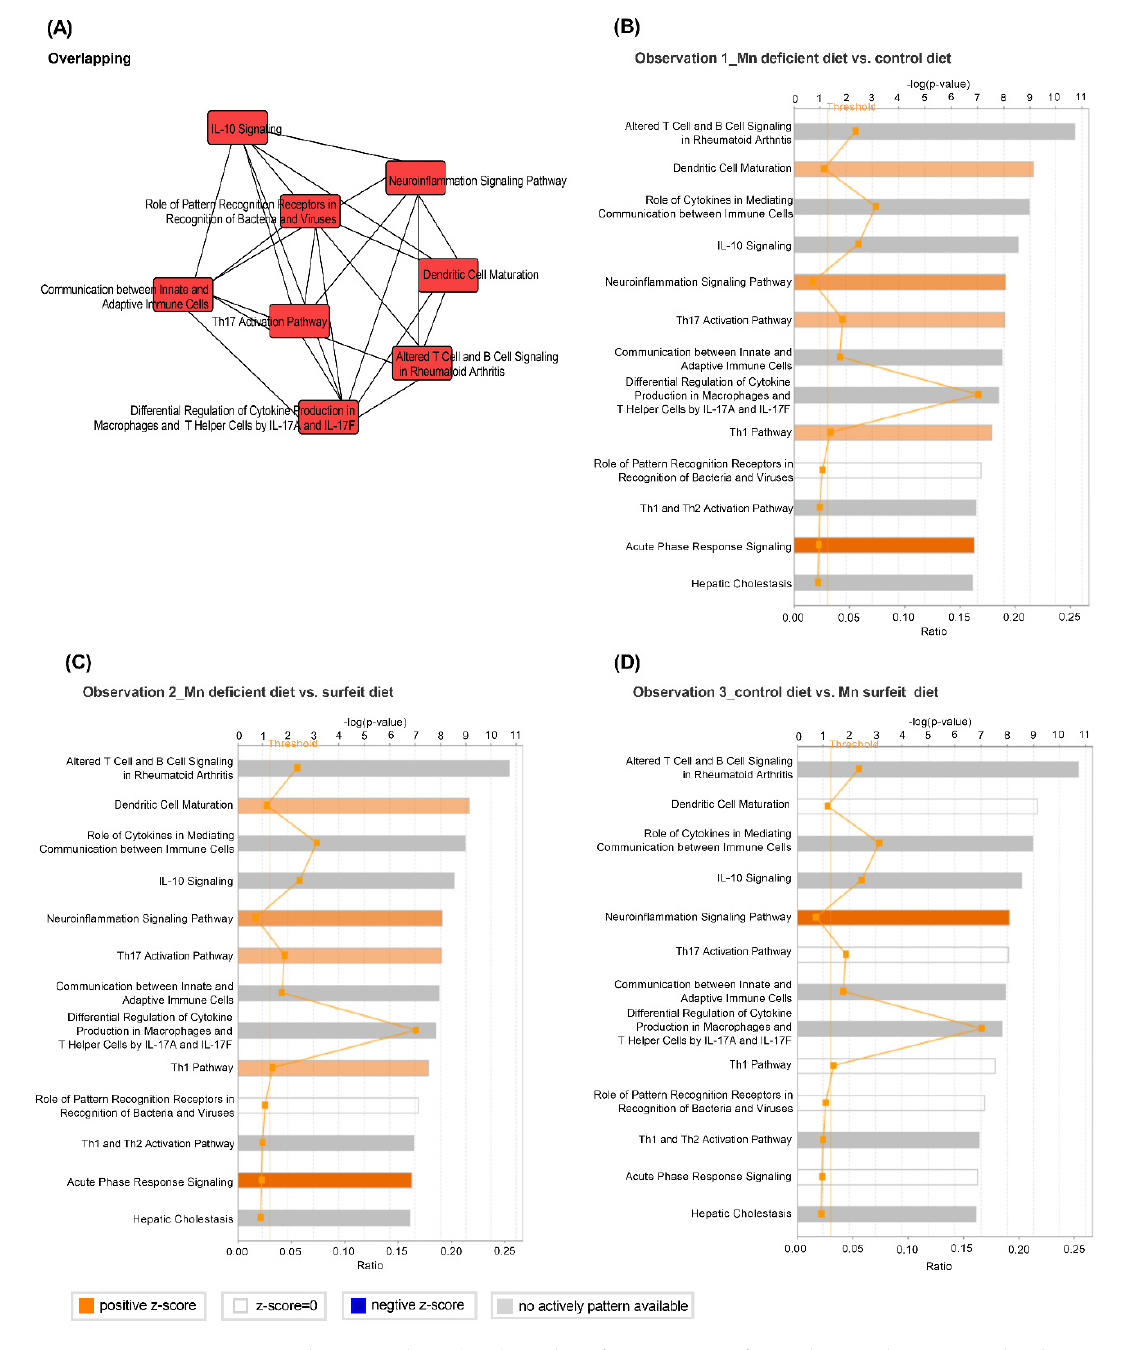
Figure 6. Ingenuity-pathway analysis (IPA) to identify activation of signaling pathways involved in dietary Mn and S . Typhimurium infection in broilers. ( A ) Top eight canonical pathways enriched by genes differentially expressed, and IPA of canonical pathways of differentially-altered genes expressed in ( B ) the Mn-deficient diet vs. the control diet; ( C ) the Mn-deficient diet vs. the Mn-supplemented diet, and ( D ) the control diet vs. the Mn-supplemented diet. A Fischer’s exact test was used to calculate a p -value.